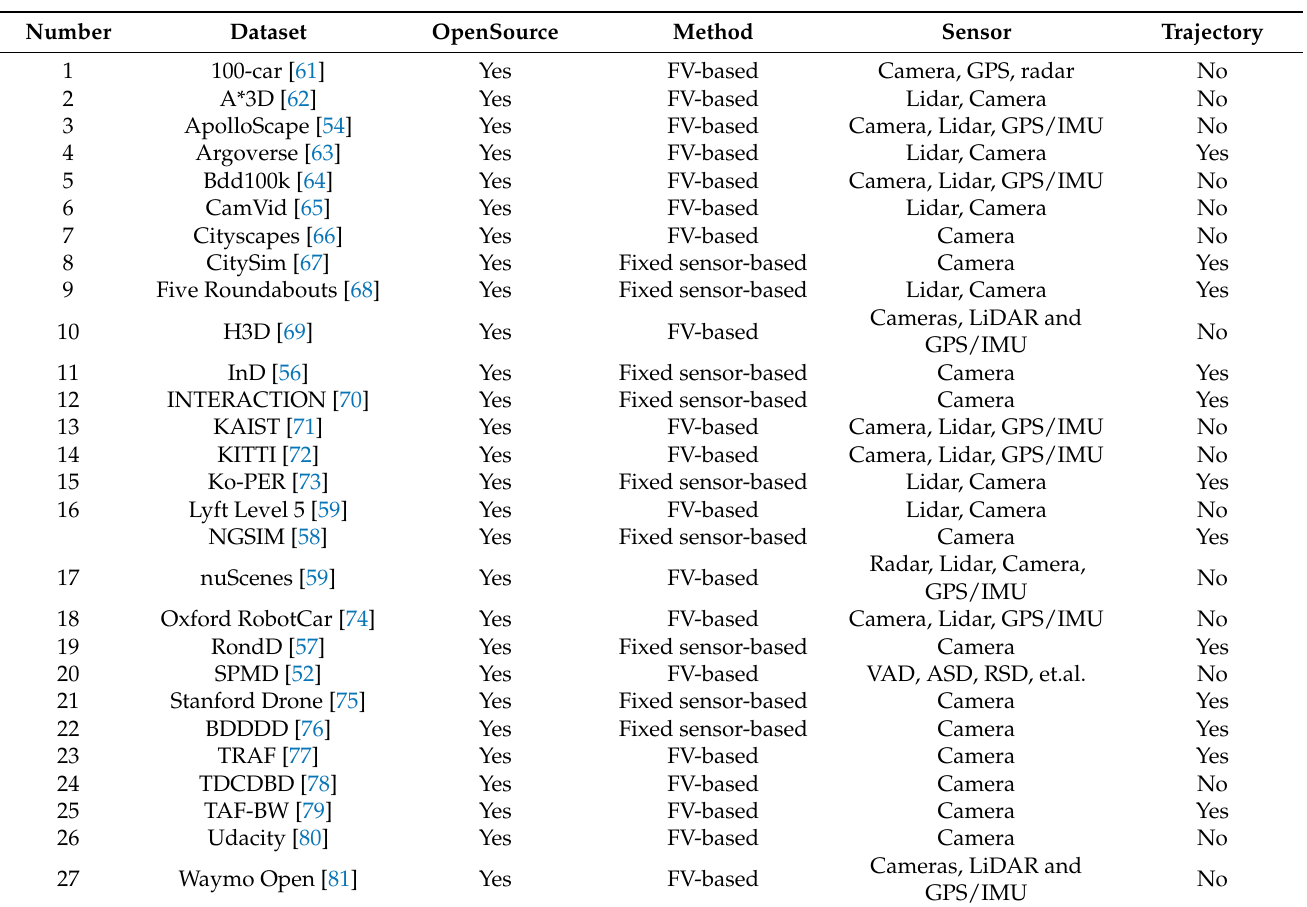
Table 1. 27 NDD dataset. “Trajectory” indicates if trajectories of all traffic agents are explicitly available in the